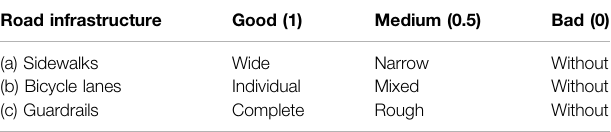
TABLE 2 | Visual interpretation judging criteria. Road